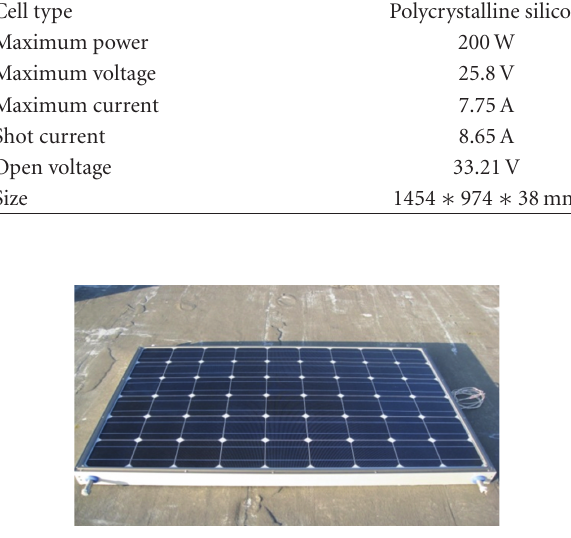
Figure 4: Unglazed PVT